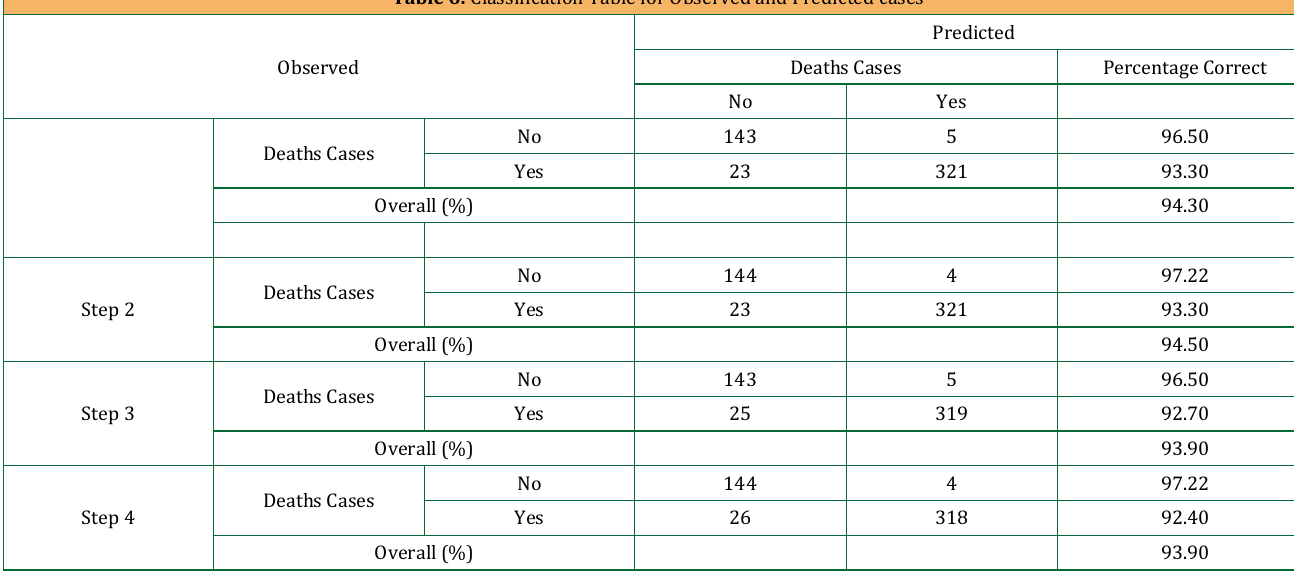
Table 6: Classification Table for Observed and Predicted